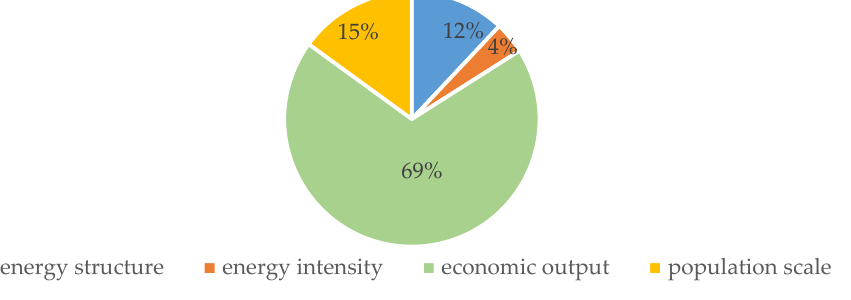
Figure 3. The influencing factors of carbon emissions from primary energy consumption in Beijing-Tianjin-Hebei (1995–2014). Figure source: The contribution rate of carbon emissions from energy consumption in Beijing-Tianjin-Hebei (1995–2014) were calculated using the GFI model.